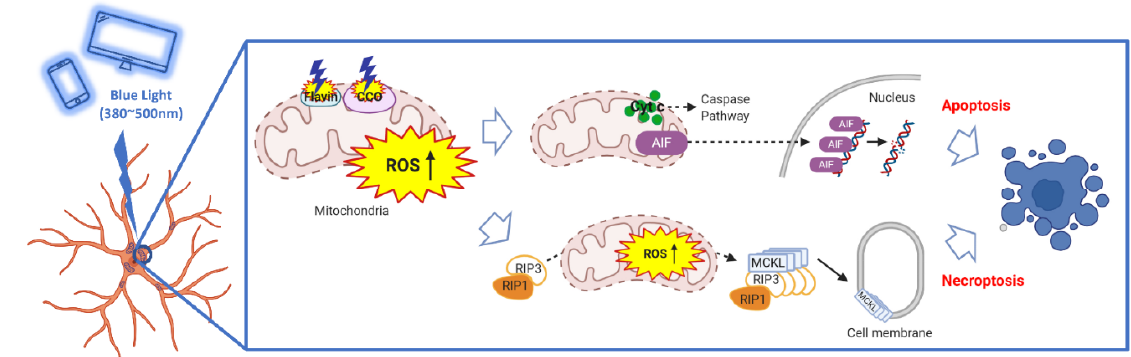
Figure 2. Schematic illustration of the proposed mechanism by which blue light causes glaucoma. This figure was created using PowerPoint & BioRender (Available online: http://biorender.com (accessed on 9 April 2020).